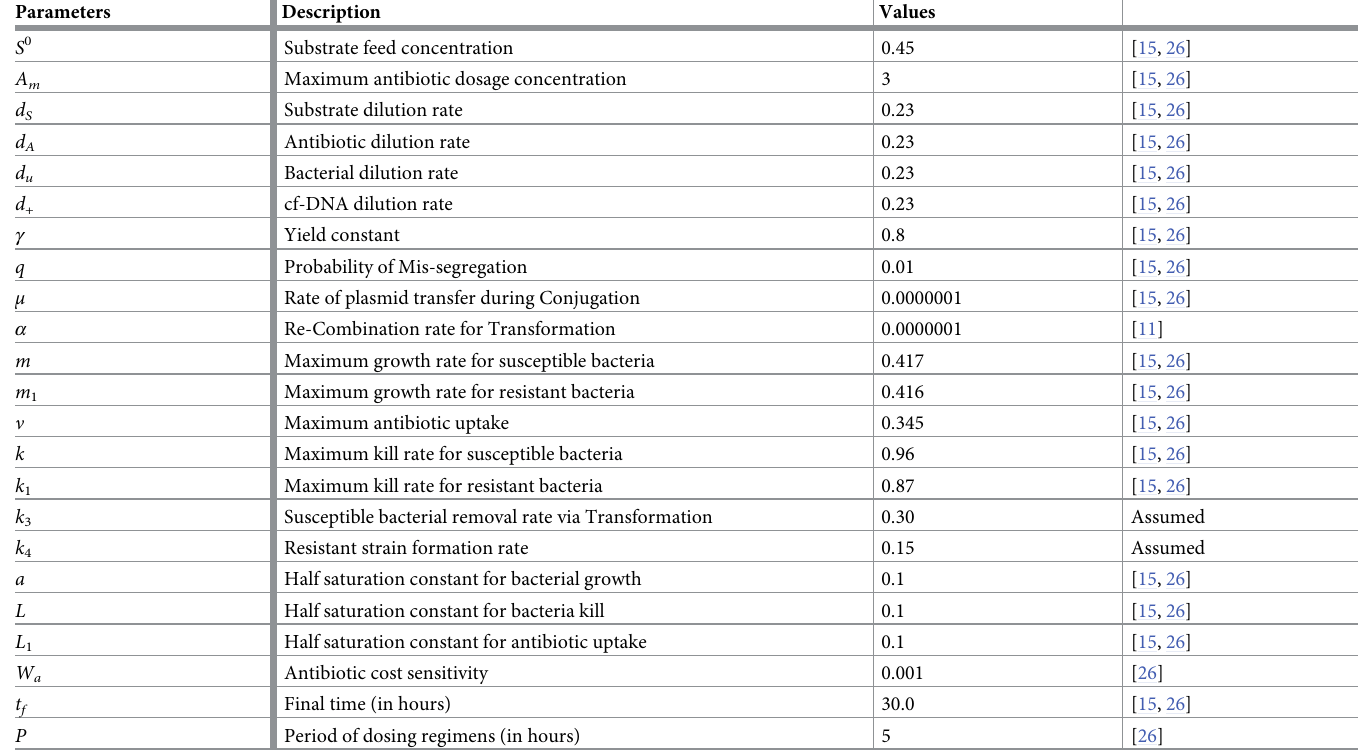
Table 2. Description of the parameters used for